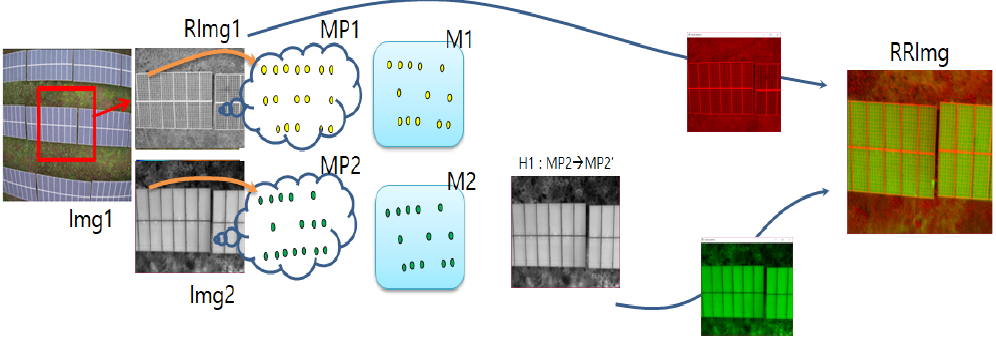
Figure 4. Segmentation, rectification, abnormal module judgment.